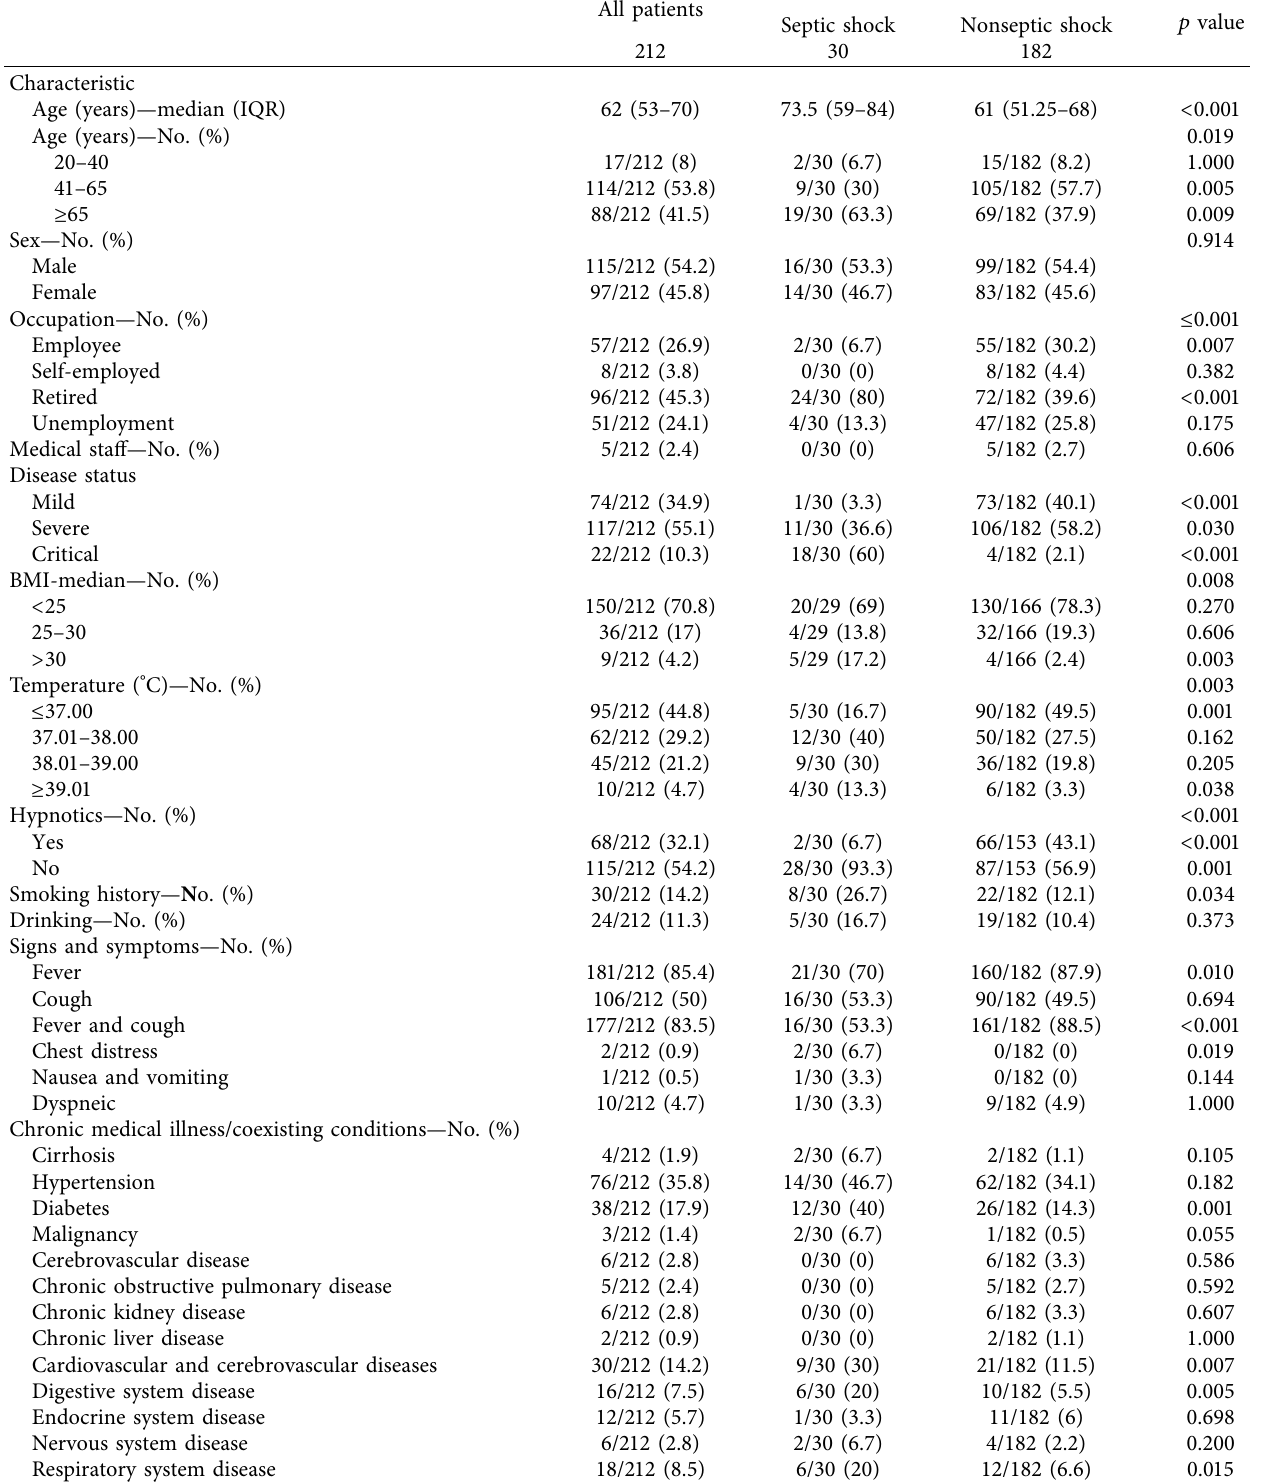
Table 1: Demographics and clinical outcomes in patients with